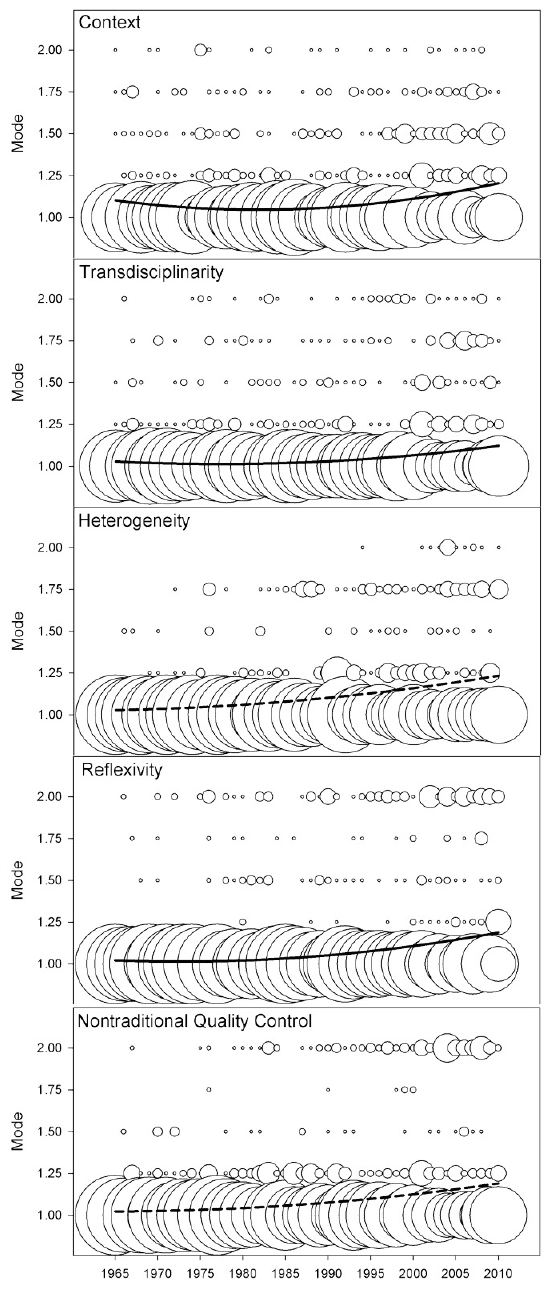
Fig. 1 . Patterns in the Mode of knowledge production in Arctic science and Mode 2 approaches over time, above and beyond differences accounted for by the influence of discipline, organization, and region in our analysis of research papers published in Arctic 1965-2010. Circles are bubbles, with size reflective of the proportion of studies in that category. Lines are 5 yr running means. Characteristics and evaluation criteria are described in Table